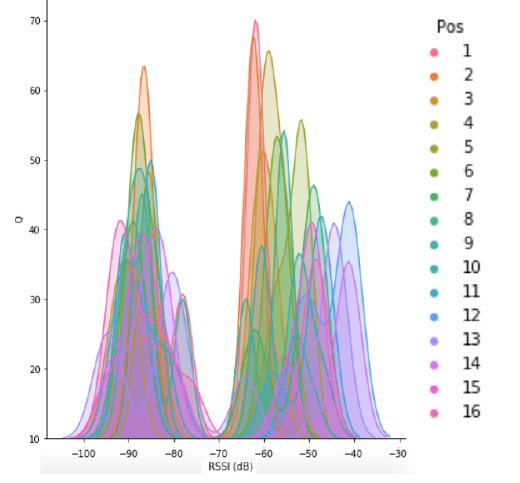
Figure 7. Link quality vs. RSSI value distribution for individual